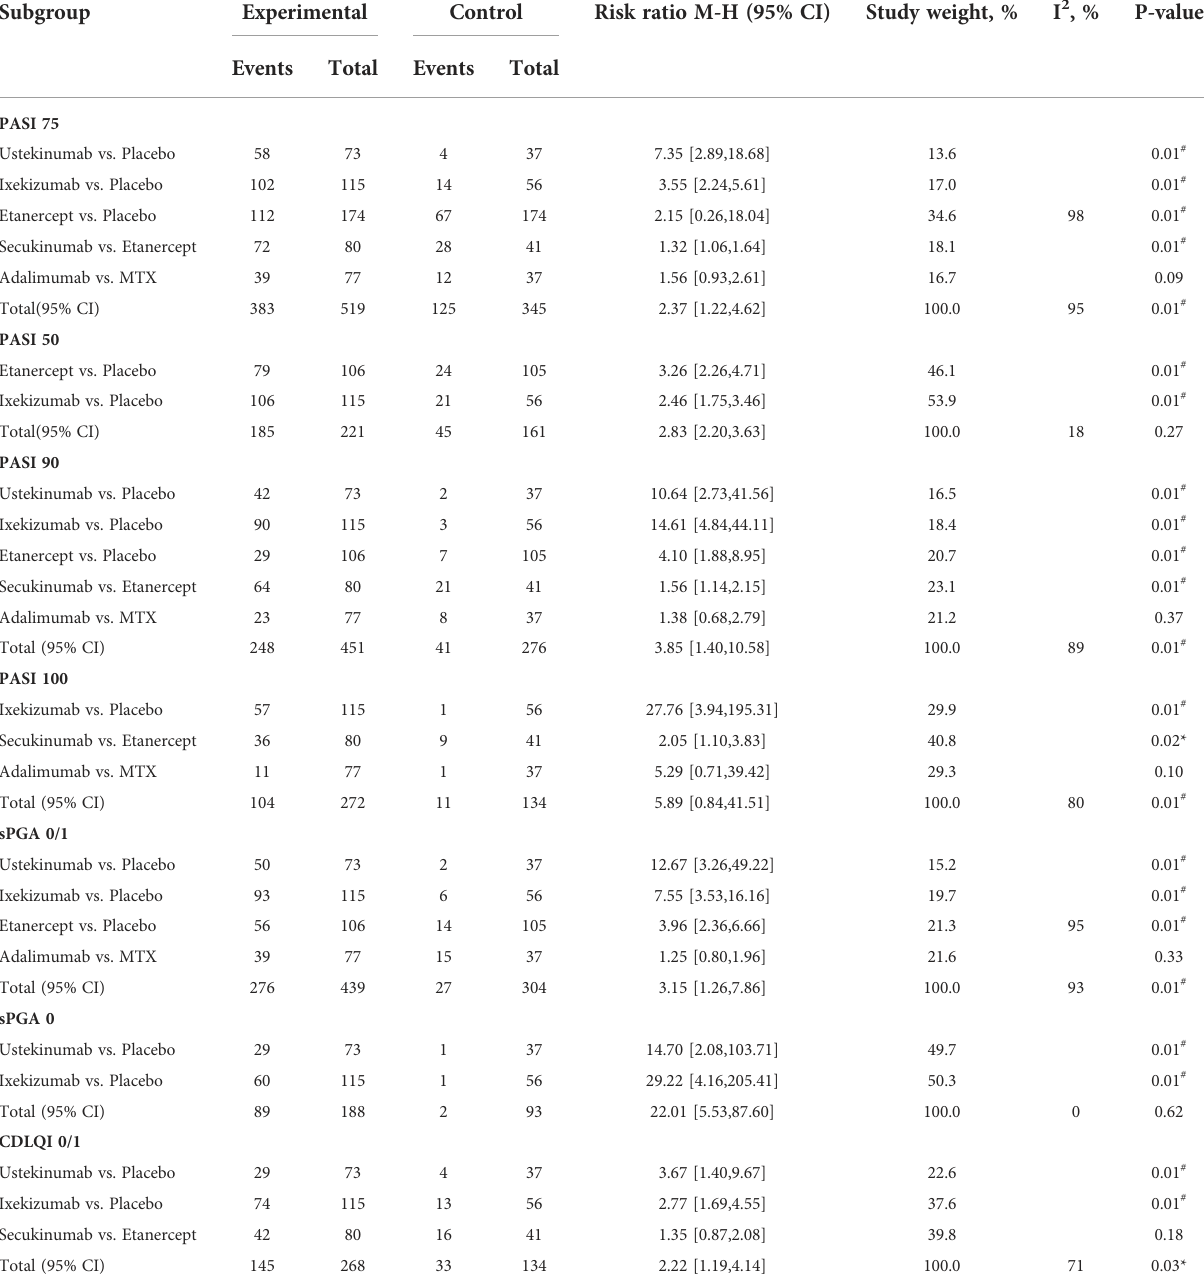
TABLE 2 Ef fi cacy of biological agents in pediatric patients with